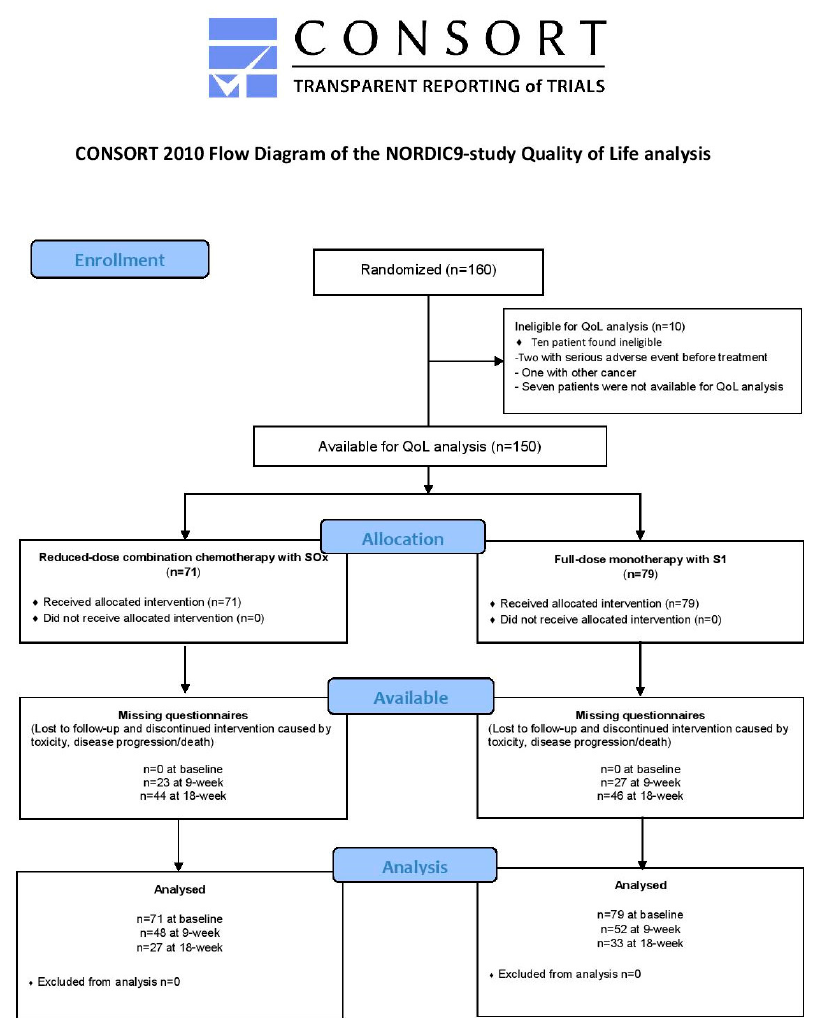
Figure 1. Patients available for quality of life analysis in the randomized NORDIC9-study, re- ported according to CONSORT flowchart.